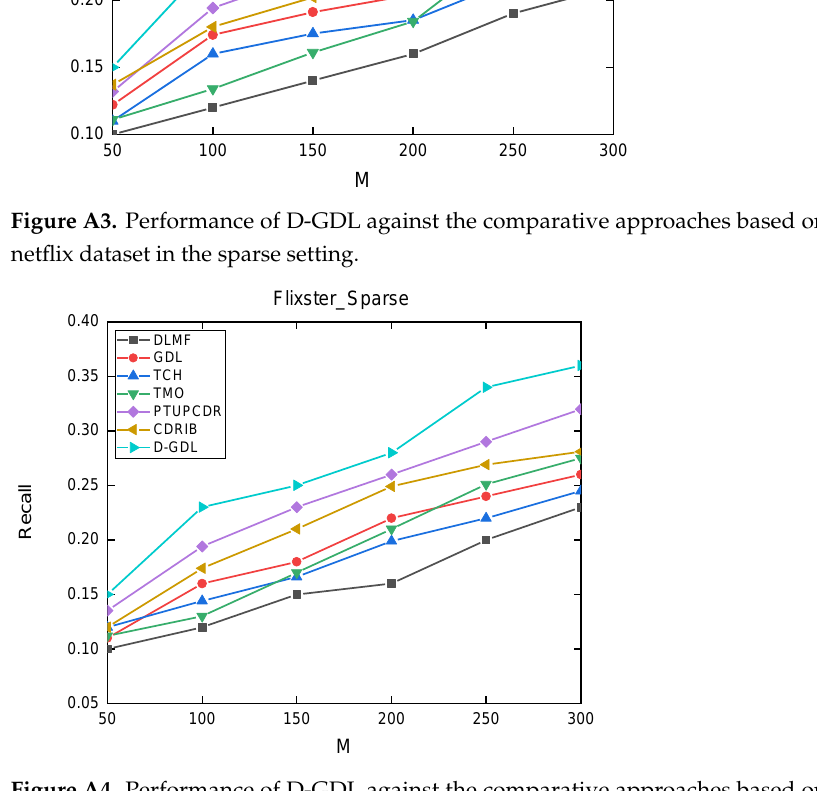
Figure A4. Performance of D-GDL against the comparative approaches based on Recall vs. M for Flixster dataset in the sparse setting.